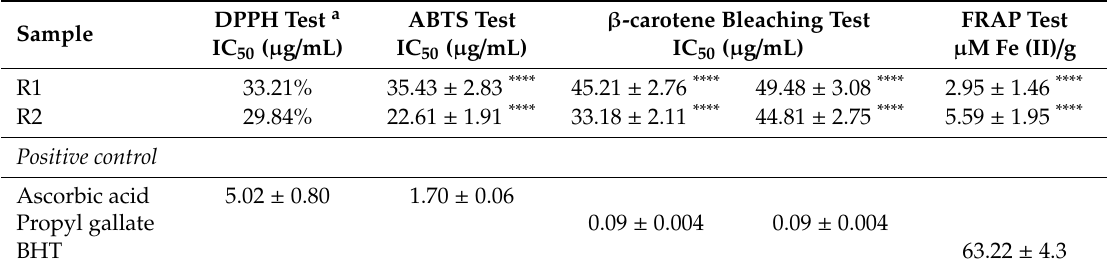
Table 3. In Vitro antioxidant activity of rosemary essential